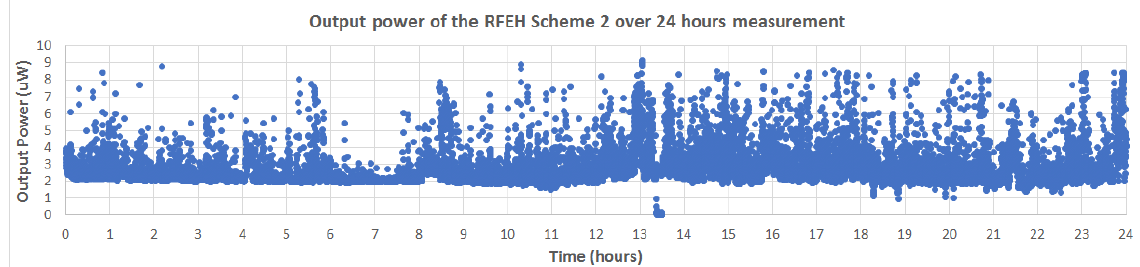
Figure 26. Output power of scheme 2 at 100 k Ω loads as measured for 24